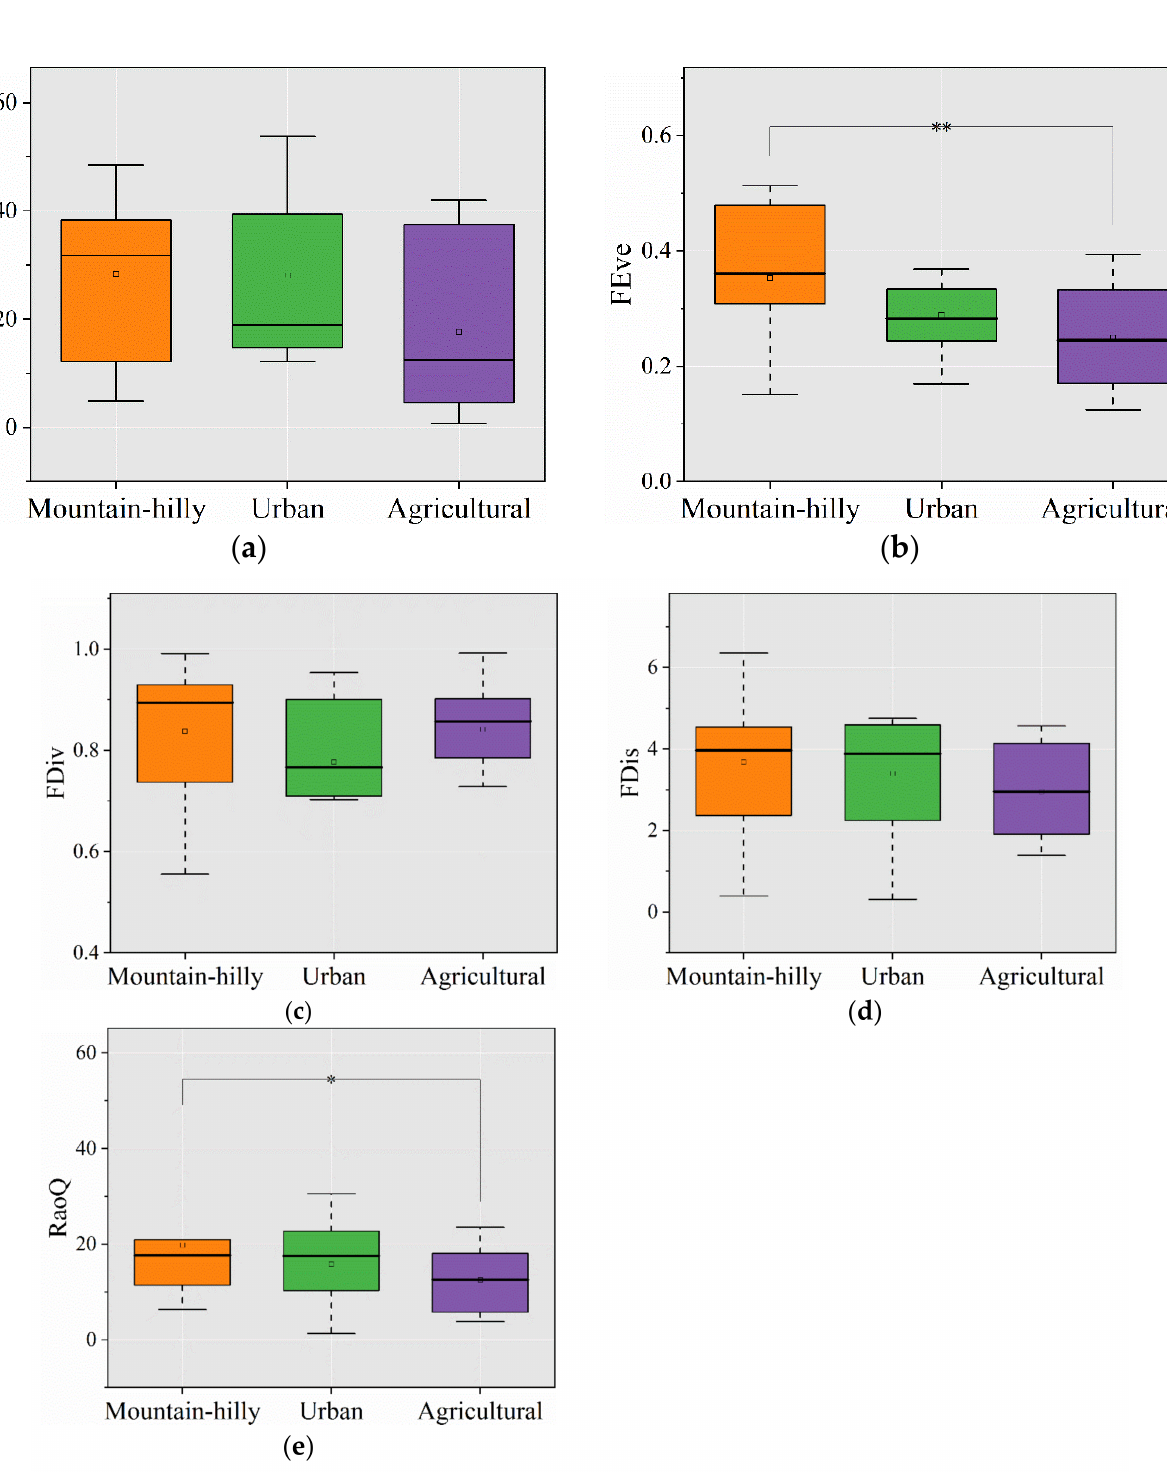
( d ) Figure 2. Box plots of taxonomic diversity indexes of richness, Simpson’s diversity, Shannon–Wie- ner index, and evenness of macroinvertebrates distributed across different land use types. The lines in the boxes represent the median, the boxes represent the 1st and 3rd quartiles, and the lines at the top and bottom of the boxes represent the 5th and 95th percentiles, respectively. ( a ) Species richness in different land use types; ( b ) species diversity in different land use types; ( c ) species Shannon– Wiener index in different land use types; ( d ) species evenness in different land use types.